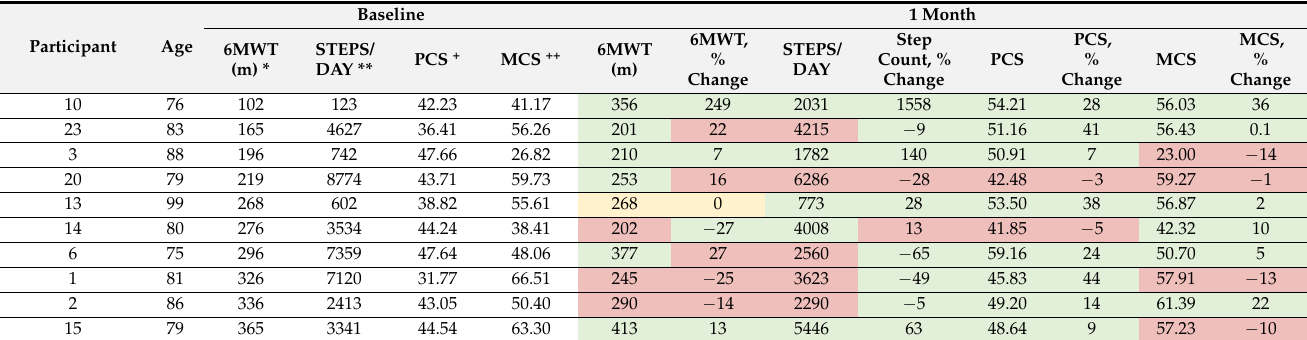
Table 3. Functional capacity, incidental physical activity, and HRQoL before and after AVR.